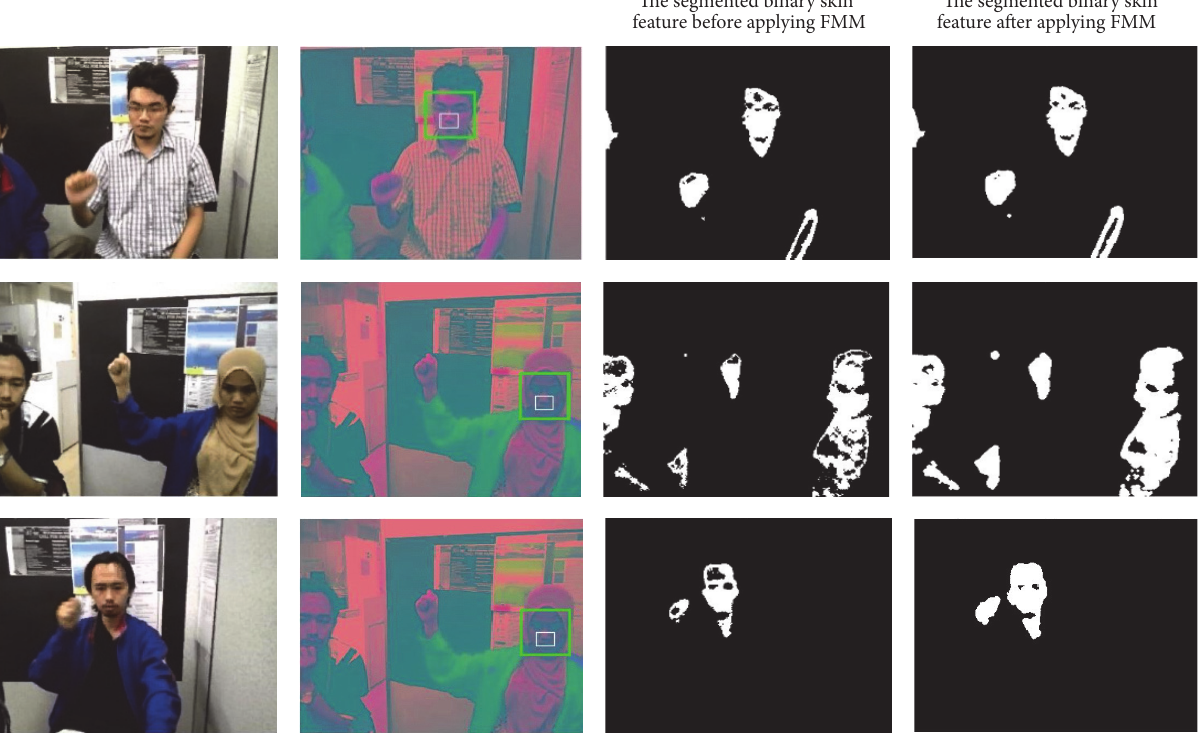
Figure 7: Skin colour segmentation using online training procedure before and after applying FMM.